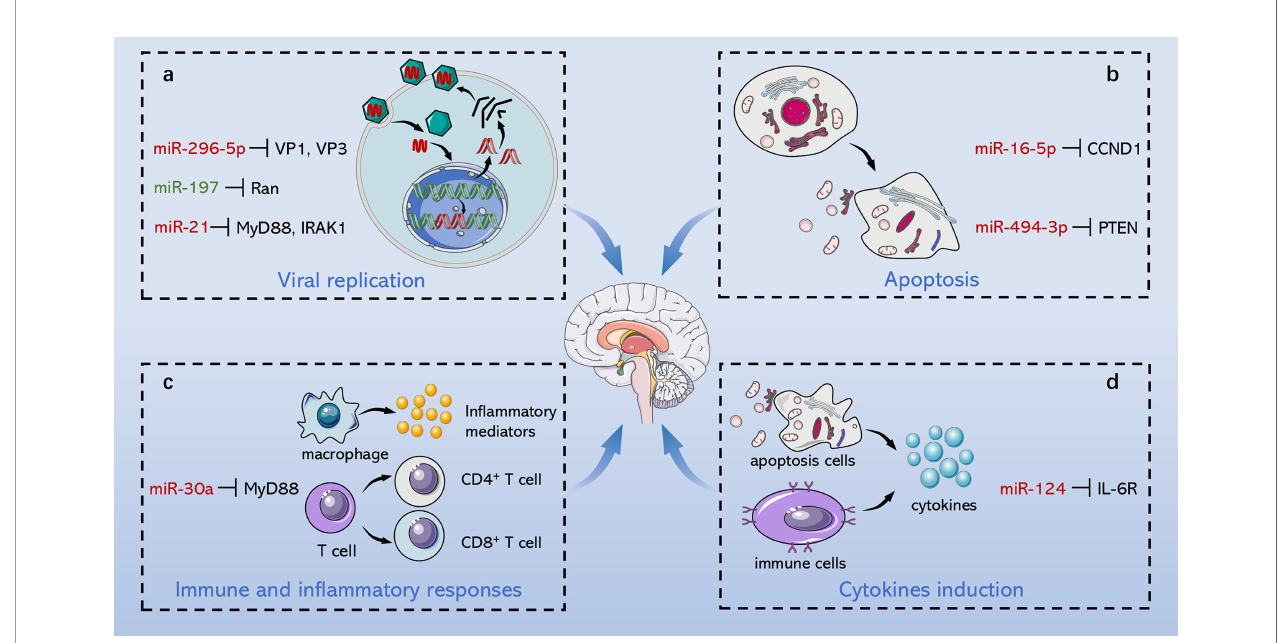
FIGURE 2 | Role of ncRNAs in central nervous system injury of EV71. EV71 injures CNS through direct damage by the virus and indirect injury mediated by immune and in fl ammatory responses. On the one hand, ncRNAs mediate direct injury of EV71 by modulating viral replication and host apoptosis. (A) miR-296-5p, miR-197 and miR-21 separately target viral genome, key host proteins and NF- k B pathway to involve in regulation of viral replication. (B) miR-16-5p and miR-494-3p respectively modulate cyclin expression and PI3K/Akt pathway to involve in regulation of host apoptosis. On the other hand, ncRNAs indirectly damage CNS through immunological concomitant in fl ammatory response and cytokines induction. (C) miR-30a promotes CNS damage by regulating immune and in fl ammatory responses, and (D) miR-124 upregulates the key pro-in fl ammatory cytokine, IL-6, aggravating damage induced by EV71. Red words indicate “ upregulation ” ; green words indicate “ downregulation ”